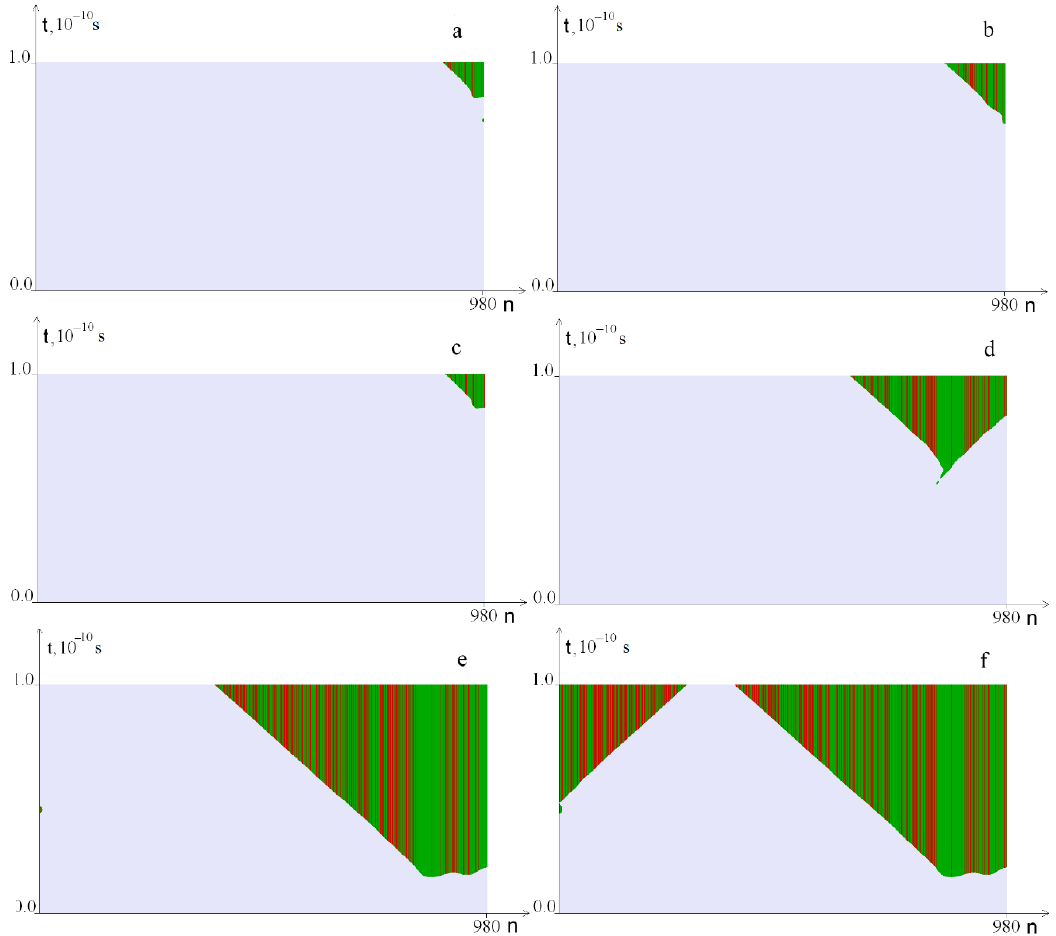
Figure 5. OS regions under different impact values of the torque on a DNA molecule M 0 : ( a ) at M 0 = 13.173; ( b )—at M 0 = 13.185; ( c )—at M 0 = 13.210; ( d )—at M 0 = 13.673; ( e )—at M 0 = 15.794; ( f )—at M 0 = 15.795. Green indicates OS in A–T pairs, red, in G–C pairs.